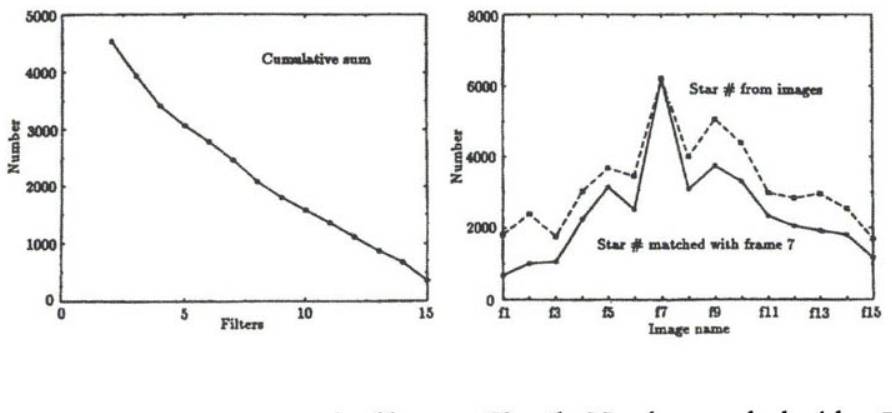
Fig 2a. NGC 288. Merge # by filter. Fig. 2b. Number matched with m7.